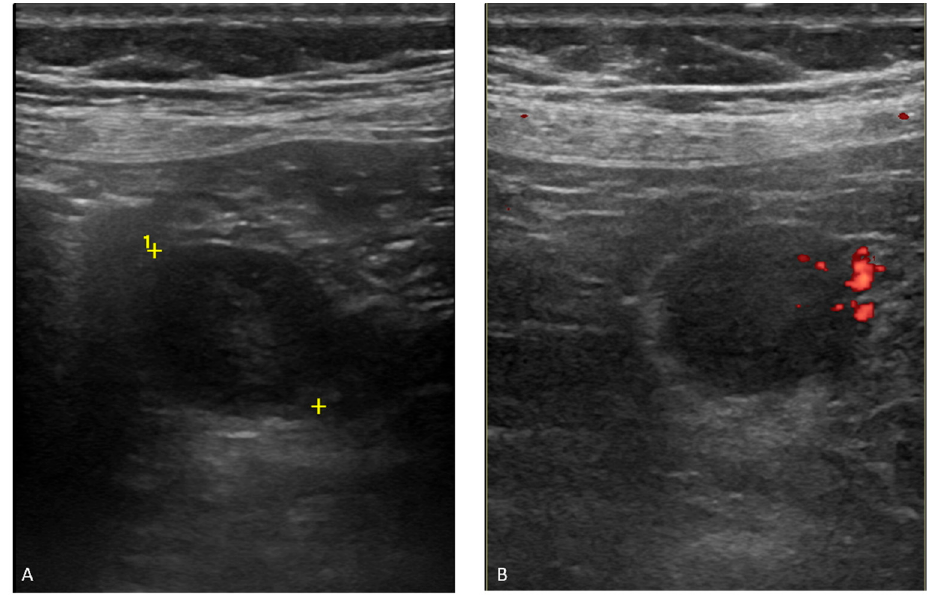
Figure 1. Abdominal ultrasound (US): ( A ) US mode; and ( B ) color Doppler. Hypoechoic area (2.3 cm), well delimited, at the jejunal level. Hypoechogenic tumoral mass, well delimited and with vascular pedicle.